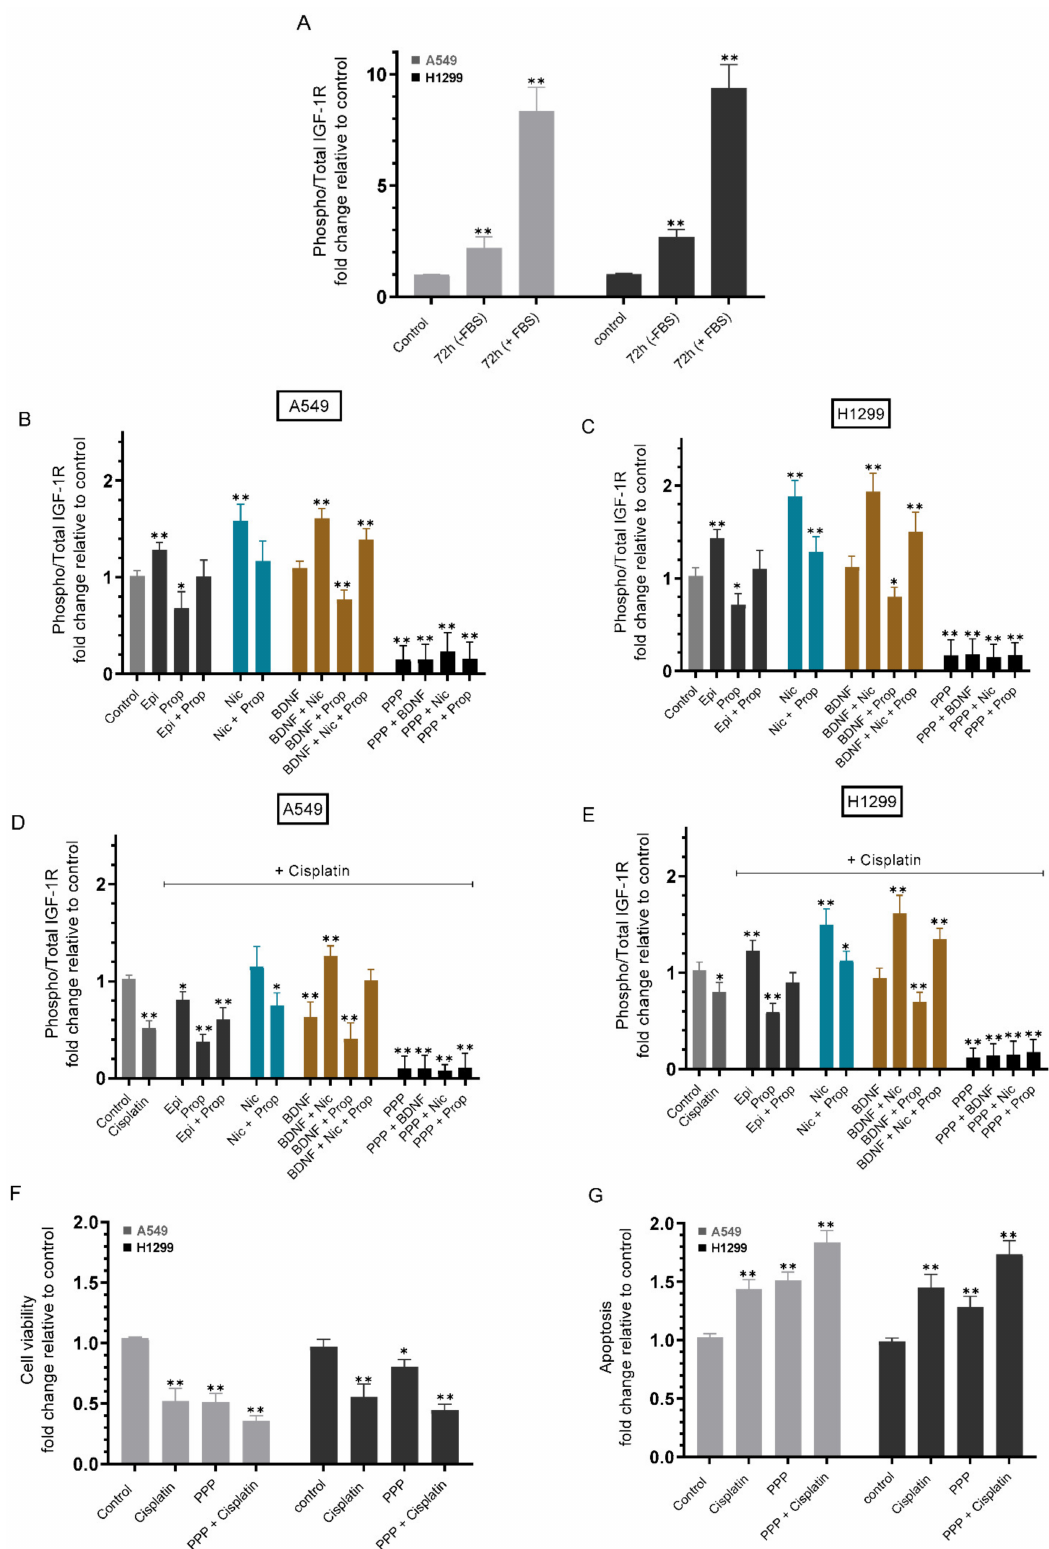
Figure 4. Phospho/Total IGF-1R ratio increased by cell treatment with epinephrine or nicotine and decreased by cell treatment with propranolol, while blocking IGF-1R activation by PPP increased